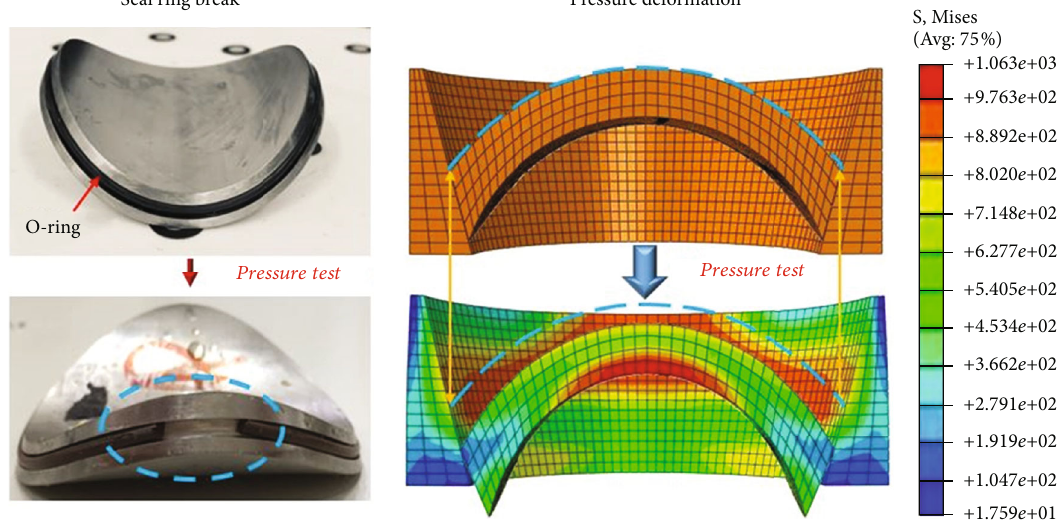
Figure 8: Deformation and damage of a pressure-maintaining